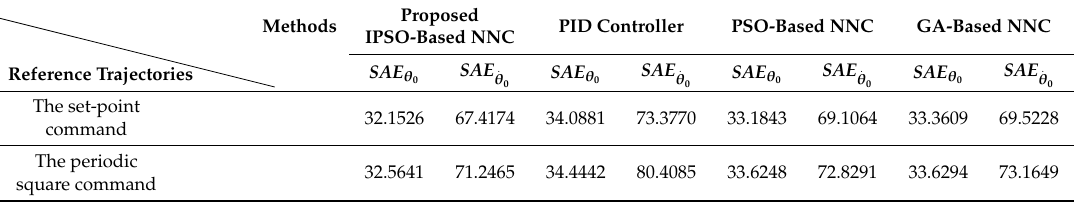
Figure 13. Tracking comparisons of ( a ) proposed IPSO-based NNC, ( b ) PID controller, ( c ) PSO-based NNC, and ( d ) GA-based NNC. Table 2. Comparison results of various controllers in the set-point and periodic square commands.